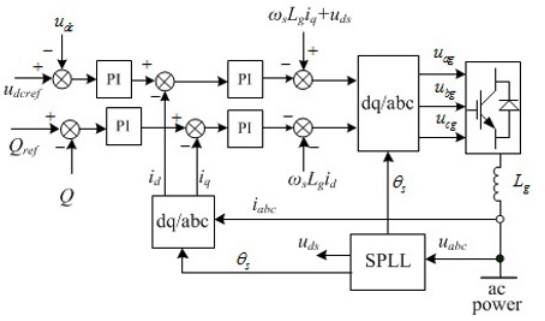
Figure 3. A typical dc voltage control